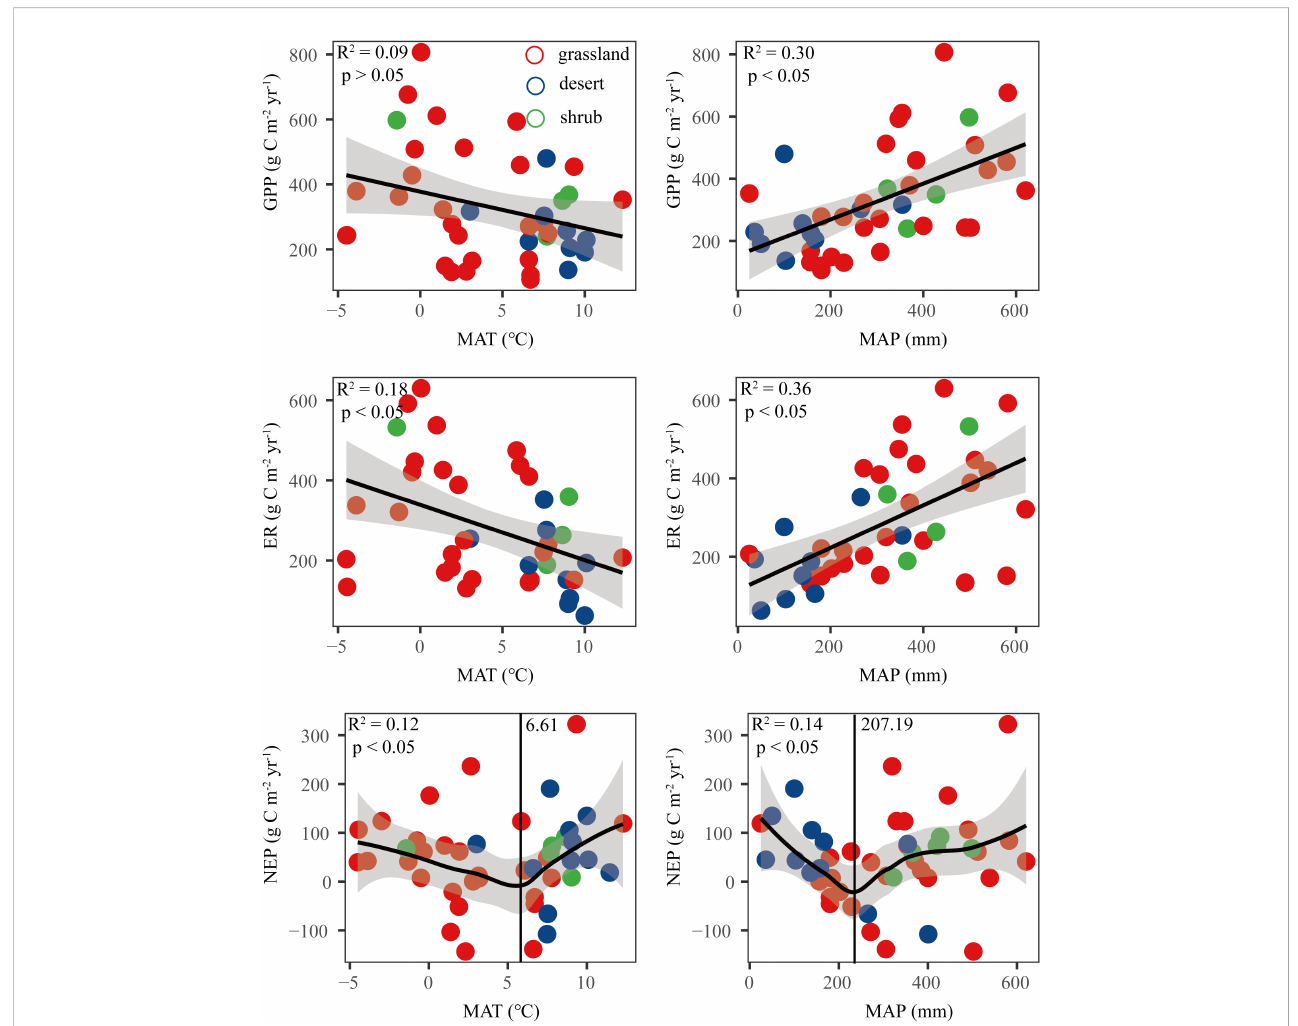
FIGURE 4 Relationships between carbon fl uxes (GPP, ER, and NEP) and mean annual temperature (MAT) and mean annual precipitation (MAP). NEP, net ecosystem productivity; GPP, gross primary productivity; ER, ecosystem